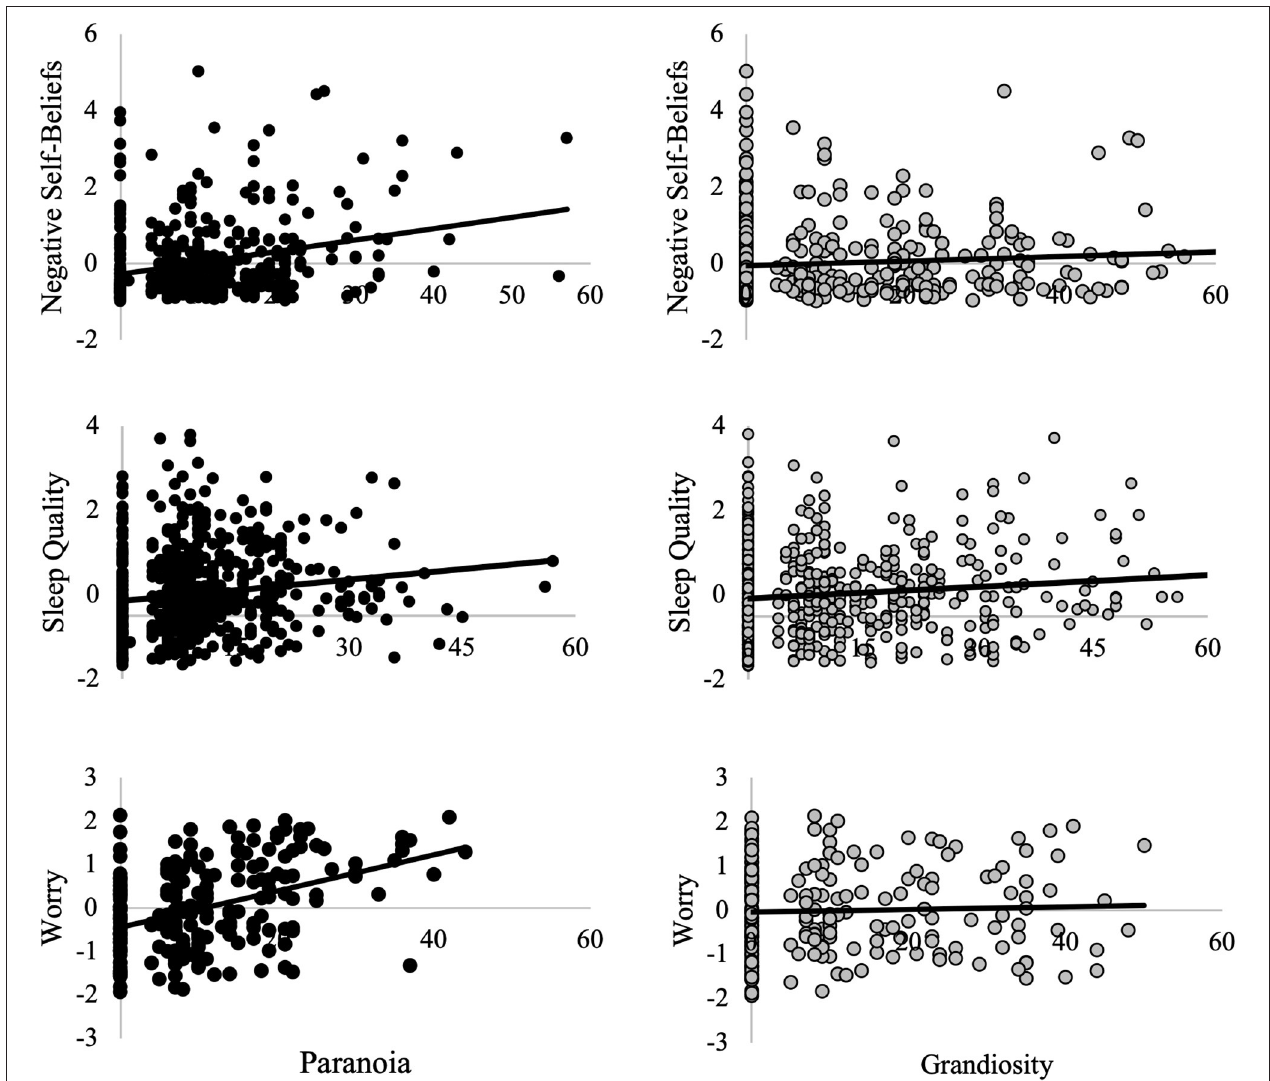
FIGURE 1 | Relationships between paranoia, grandiosity, and contributory factors. Worry, negative self-beliefs, and sleep quality are presented as residuals, controlling for age, sex, race, and the number of days between when the two self-report measures were conducted (“day lag”). Worry was measured throught the Penn State Worry Questionnaire (PSWQ). Negative self-beliefs was measured through the Beck Depression Inventory (BDI-II) and Adult Self-Report Scale (ASR). Sleep quality was measured using the Pittsburgh Sleep Quality Inventory (PSQI). Paranoia and grandiosity were measured with the Peters Delusions Inventory